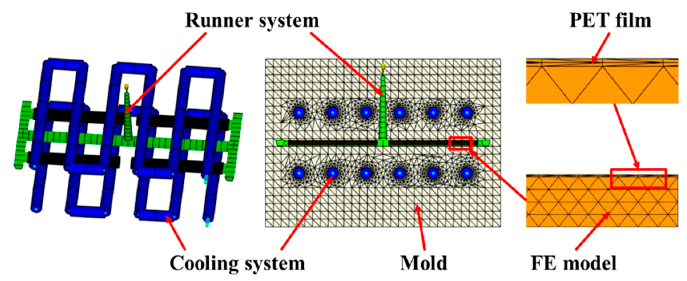
Figure 2. Finite element model.